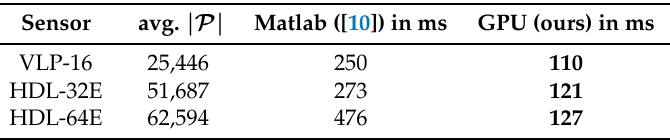
Table 1. Computation times of our GPU implementation of the M2DP descriptor compared to the CPU version implemented in Matlab by [10]. The speed-up factor for data originating from the HDL-64E is almost × 4, whereas for the VLP-16 and HDL-32E the speed-up factor is × 2.5. avg. |P|